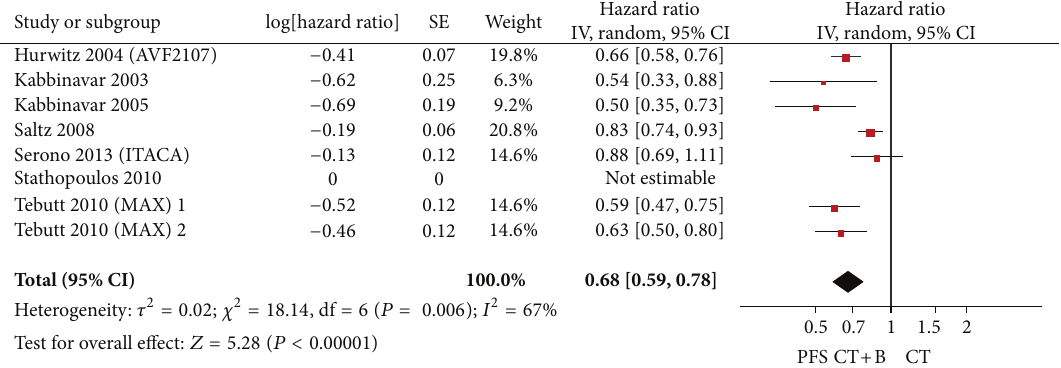
a much narrower 95% confidence interval (from 95% CI = 0.78–1.02 to 95% CI = 0.83–1.05) and better homogeneity (from 𝐼 2 = 61 %, 𝑃 = 0.02 to 𝐼 2 = 47 %; 𝑃 = 0.15